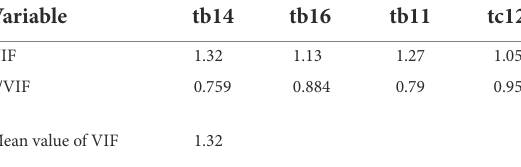
TABLE 2 Results of multicollinearity test.